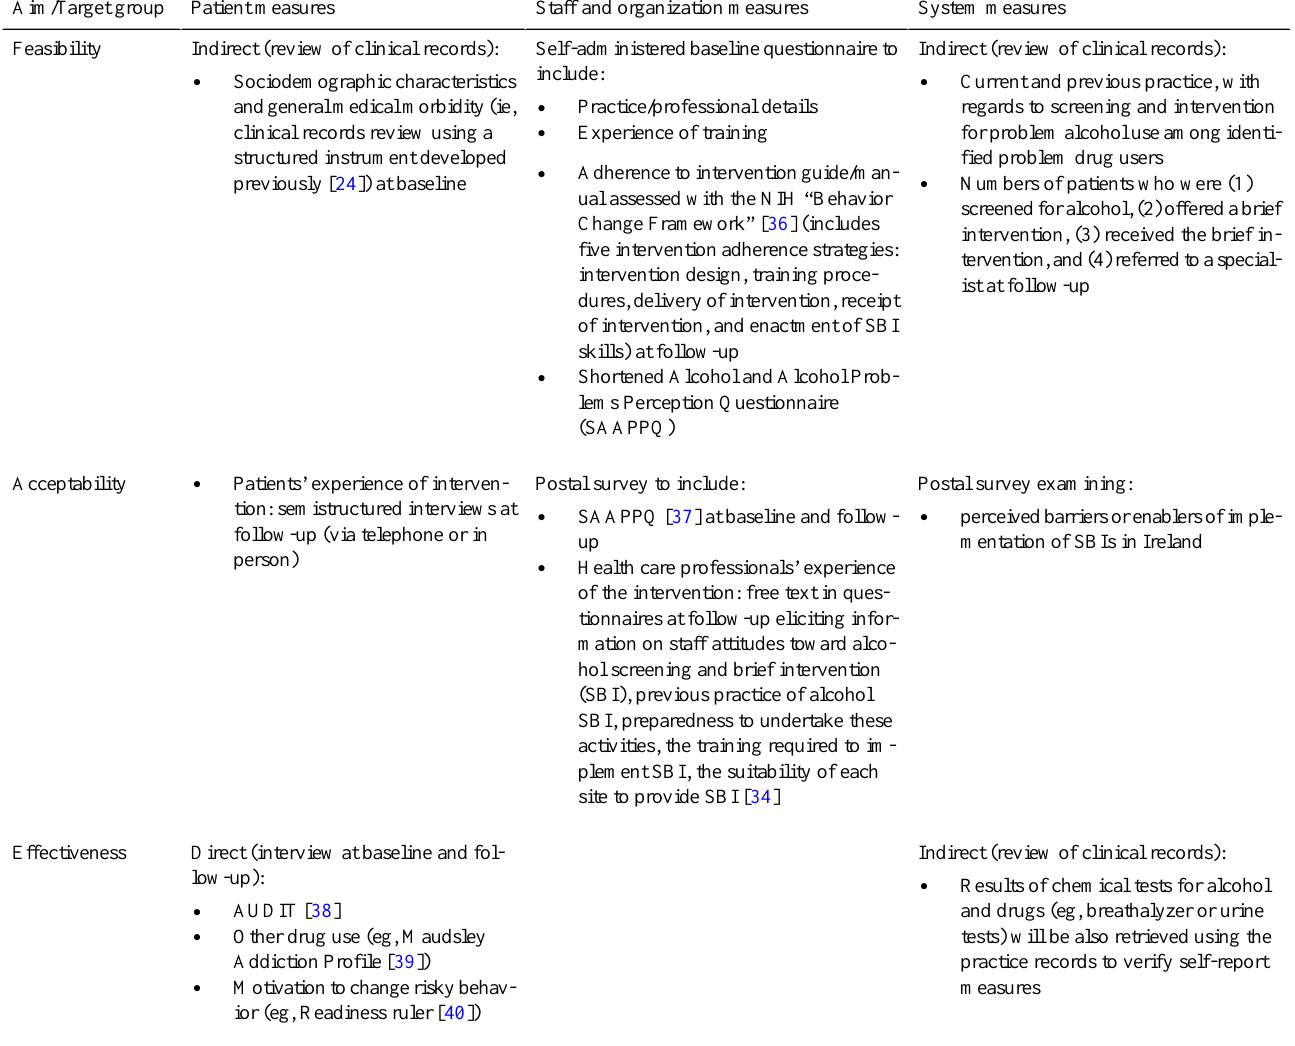
Table 1. Primary and secondary outcome measures to be used at the baseline and/or follow-up